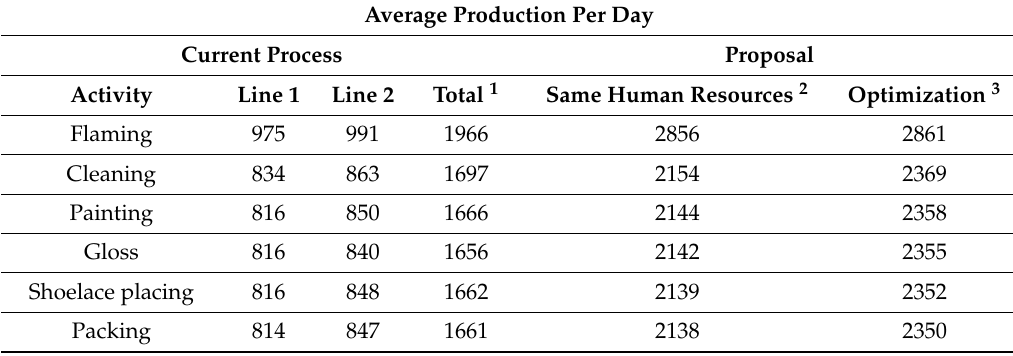
Table 8. Comparison of average production per day